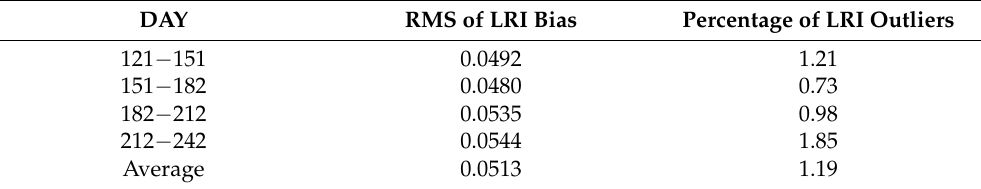
Table 1. RMS of LRI bias (unit: m) and percentage of LRI outliers (unit: %). DAY RMS of LRI Bias Percentage of LRI Outliers 121 − 151 0.0492 1.21 151 − 182 0.0480 182 − 212 Average 0.0513